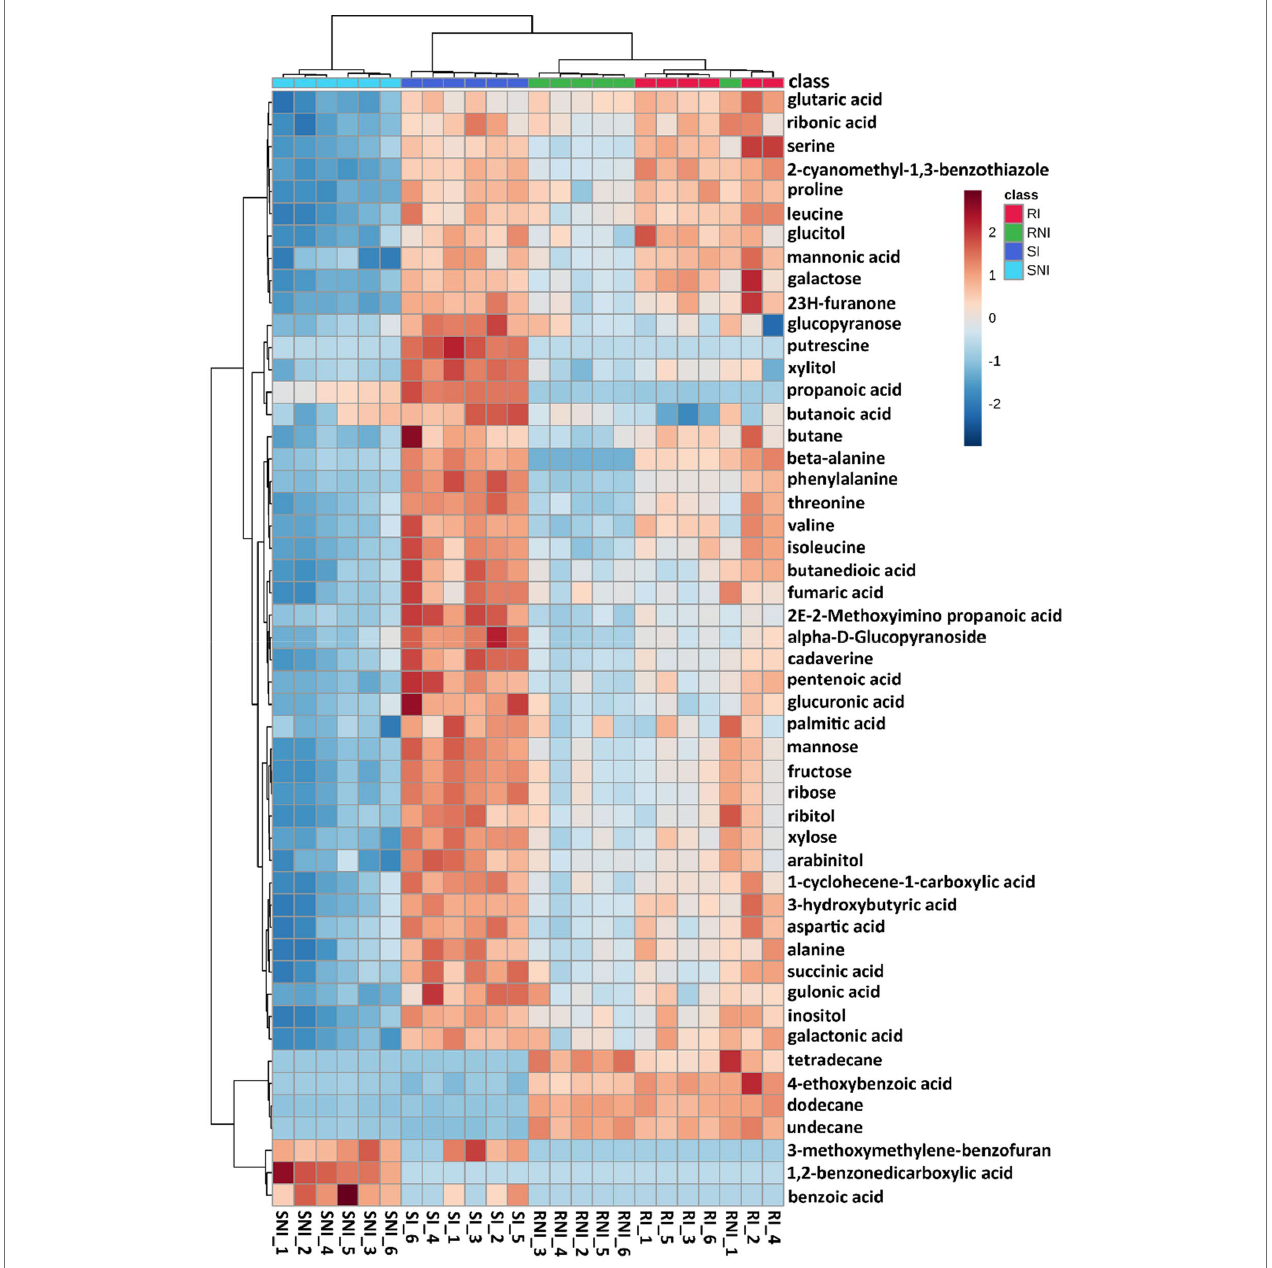
FIGURE 2 | Metabolome of tobacco (susceptible cultivar Yunyan87 and moderately resistant cultivar K326) in response to R. pseudosolanacearum infection. Heatmap of differentially expressed metabolites in tobacco cultivars (Yunyan87 and K326) in response to R. pseudosolanacearum invasion. Columns correspond to experimental